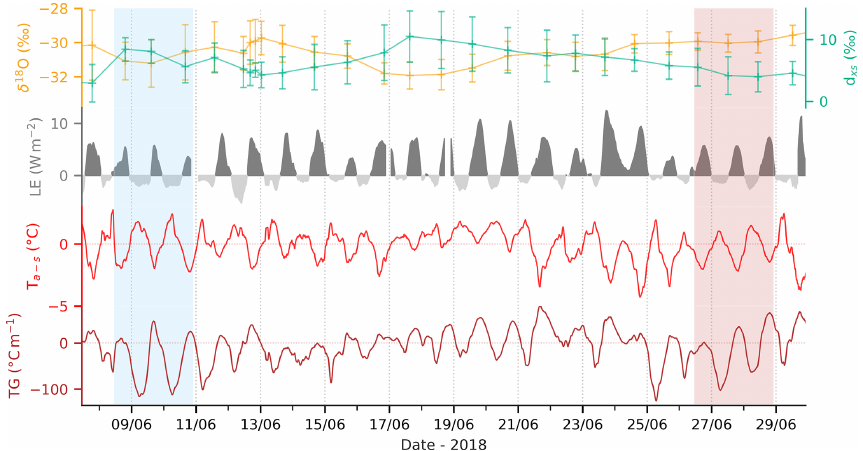
Figure 7. LE and temperature gradients for low-wind events. Latent heat flux (LE) (grey), air-surface temperature gradient (TG) (bright red) and surface-10cm subsurface TG (dark red) during June 2018. E10 (blue) and E11 (red) are highlighted. Dark grey shading in LE indicates sublimation and light grey shows